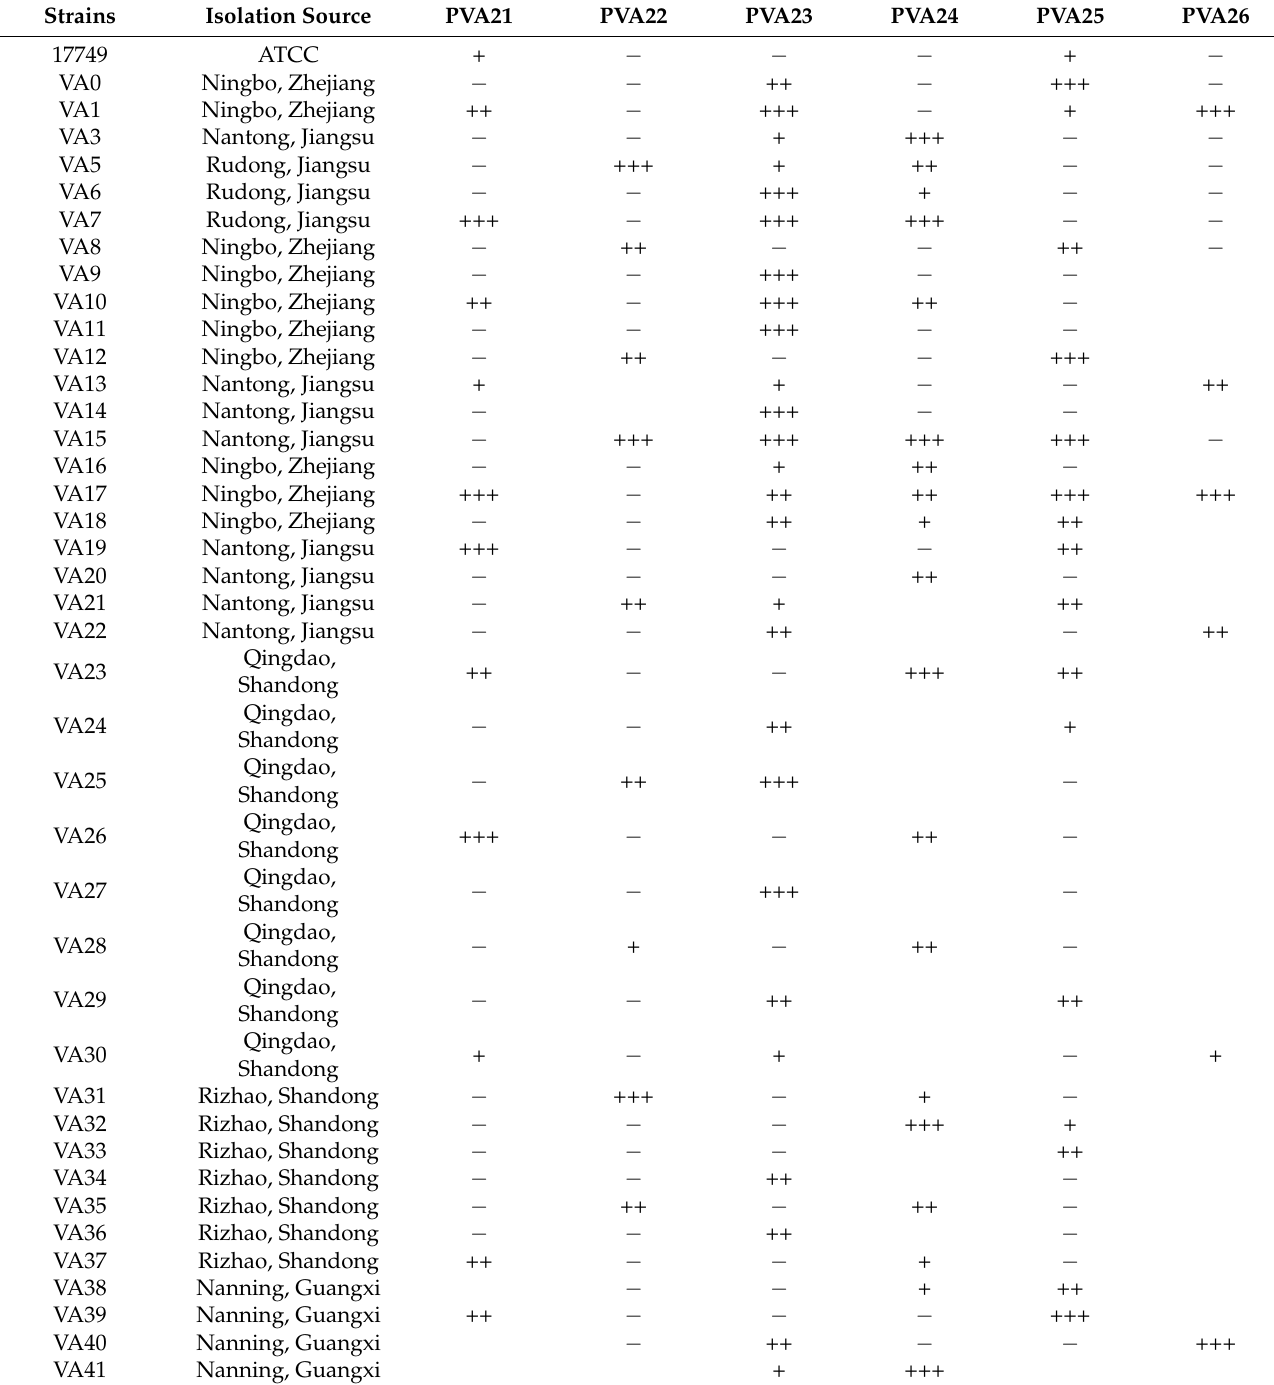
Table 2. Host range of the isolated phages to the V. alginolyticus